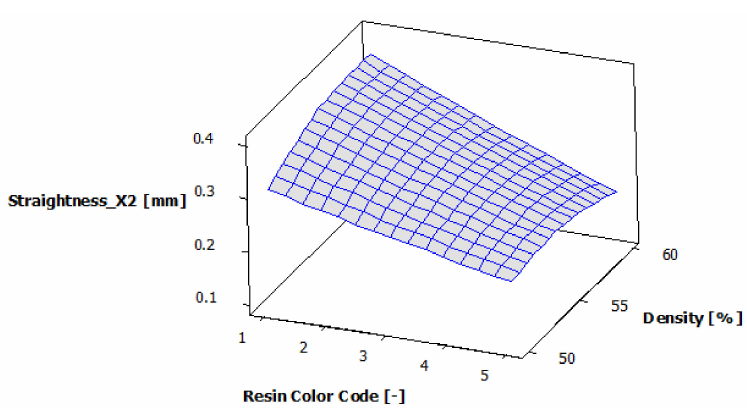
Figure 18. Estimated response surface for Straightness_X2.